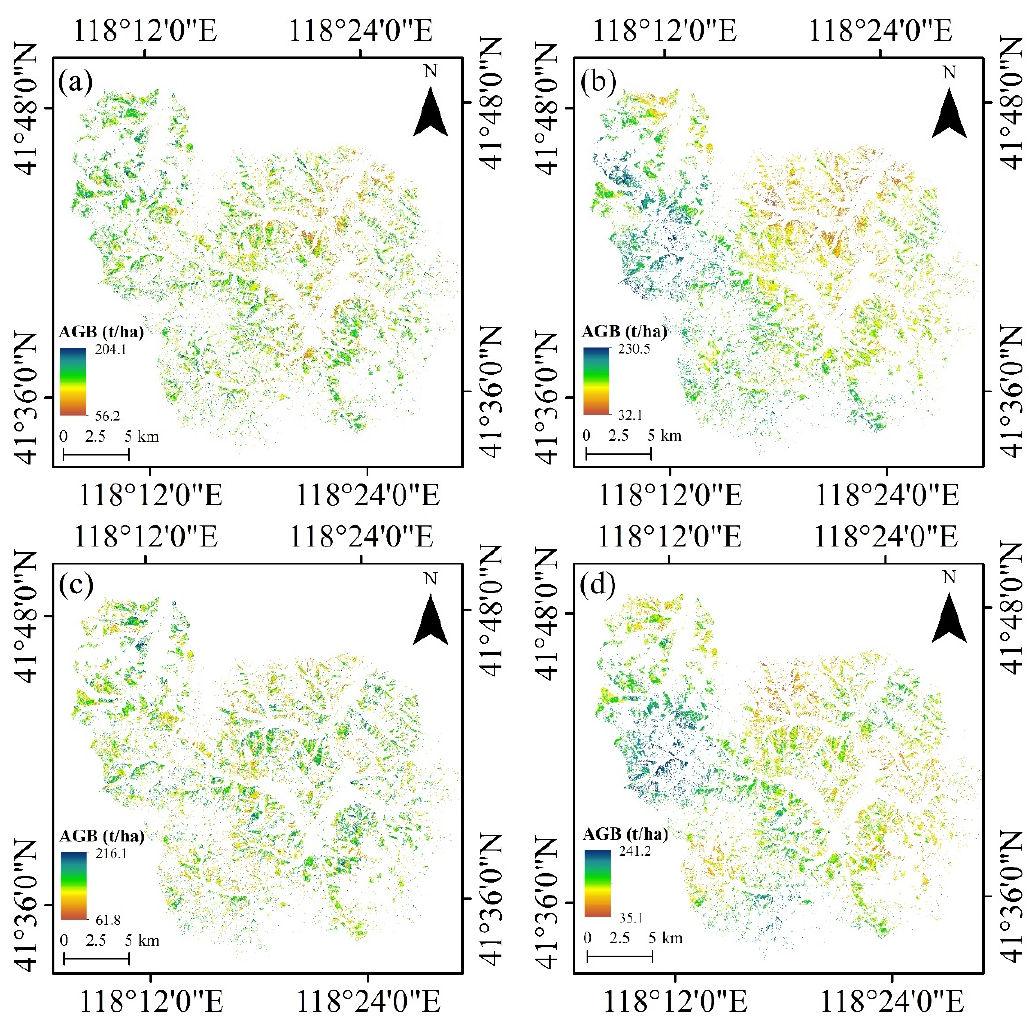
Figure 6. Spatial distributions of forest AGB in Wangyedian using ( a ) the Landsat 8 with RF, ( b ) the Landsat 8 with regression kriging, ( c ) the Landsat 9 with RF, and ( d ) the Landsat 9 with regression kriging.